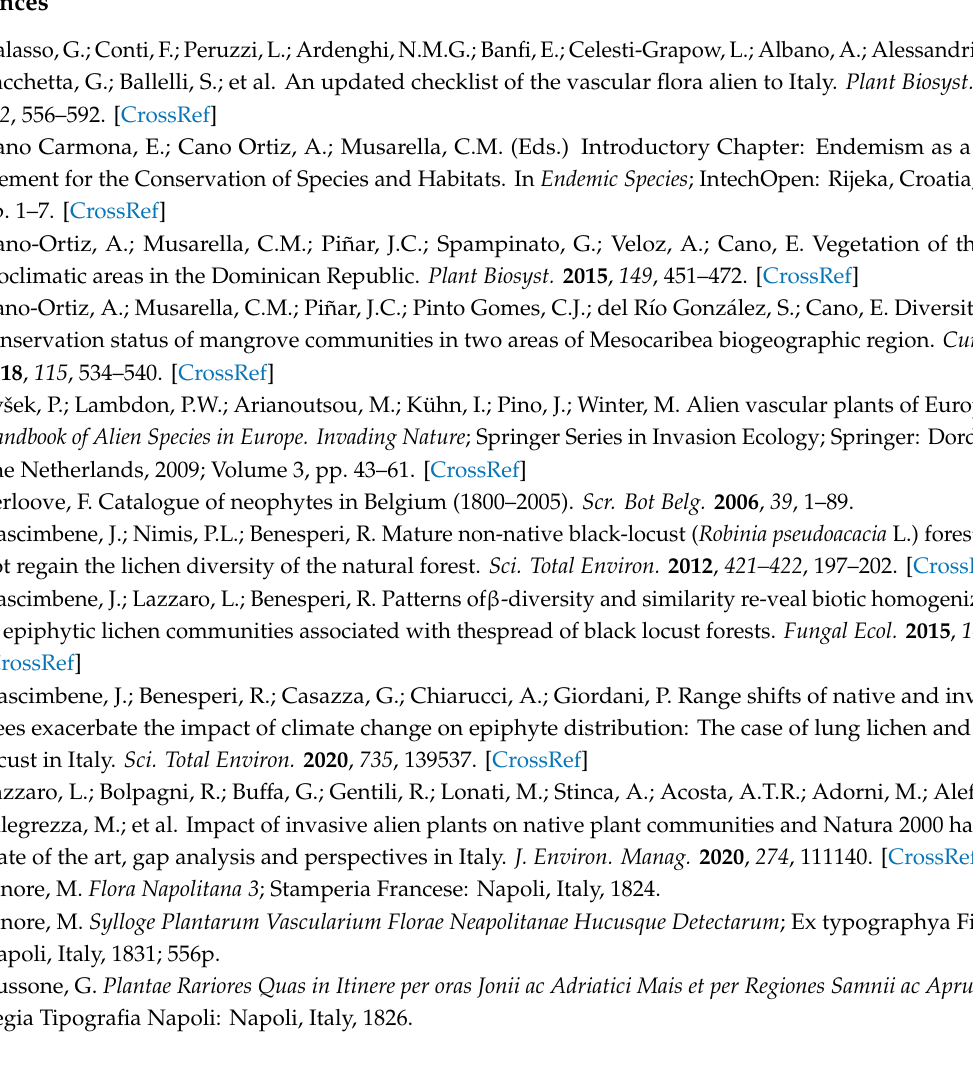
Figure A11. Juvenile of Tradescantia sillamontana Matuda found in a crevice in Contrada Monte Callea (Reggio Calabria province) (Photograph VLA Laface).